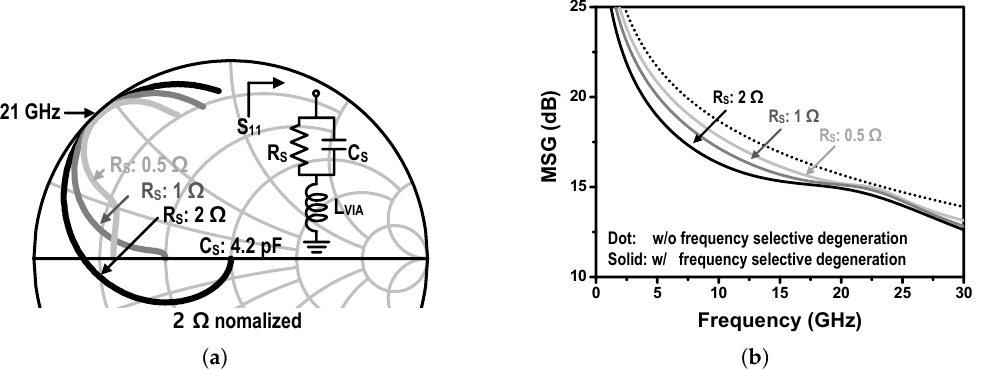
Figure 3. Frequency characteristics according to the resistor values with a capacitance of 4.2 pF, ( a ) S11 for the frequency selective degeneration circuit, ( b ) MSG of the